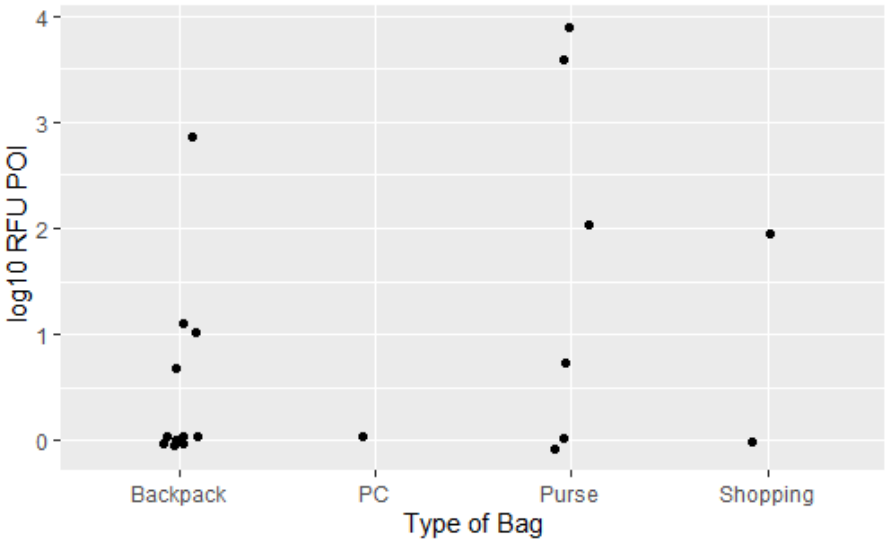
Figure 2. Dot plot displaying the log 𝑅𝐹𝑈(cid:3364)(cid:3364)(cid:3364)(cid:3364)(cid:3364)(cid:3364) values detected in the samples collected from zip-lock (cid:2869)(cid:2868) drugs bags after storage in a previously used personal bag (backpack, PC bag, purse/handbag or shopping bag).